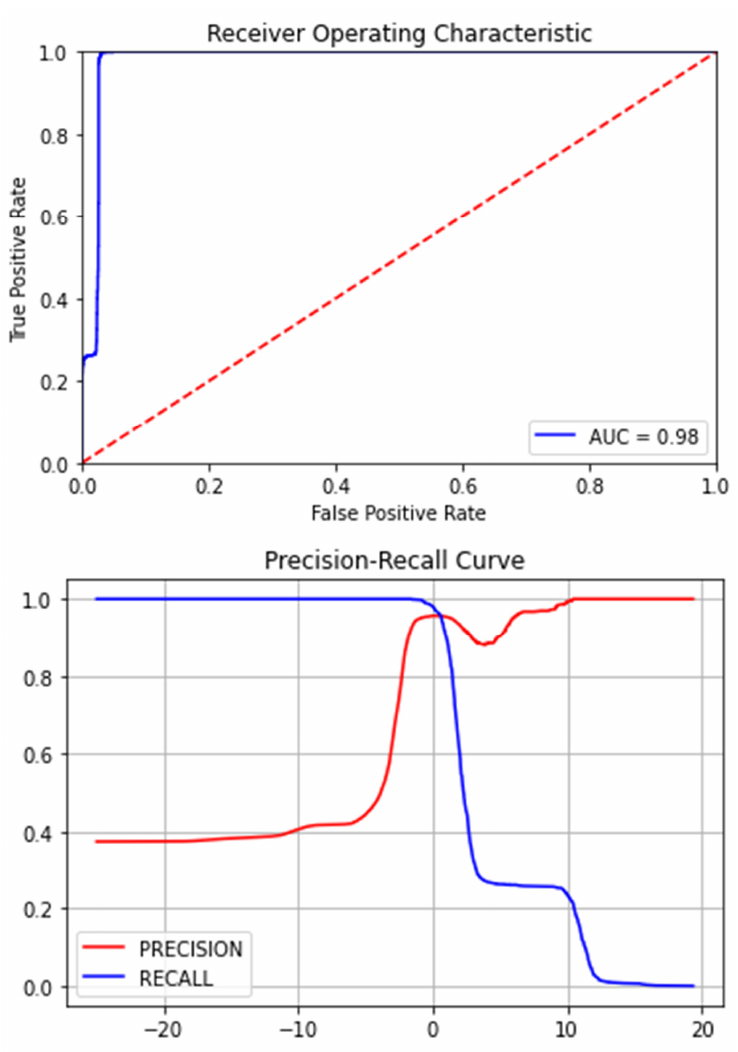
Figure 7. AUC and Precision-Recall Curve for Logistic Regression.